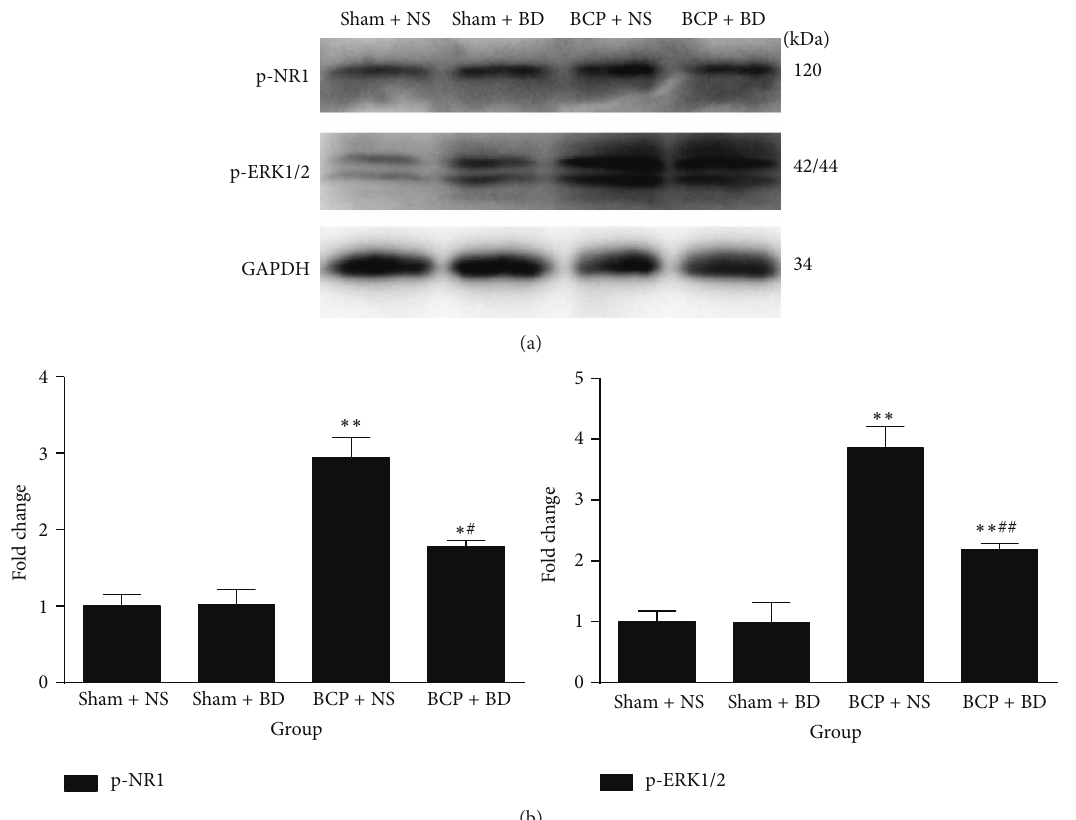
Figure 5: Blocking sigma-1 receptor activation suppressed BCP-induced upregulation of p-NR1 and p-ERK1/2 in the spinal cord. (a) Western blot analysis indicated a significant increase of p-NR1 and p-ERK expression in the spinal cord of BCP rats on day 7. Repetitive treatment with BD1047 significantly decreased these molecules in BCP rats compared with NS-treated BCP group. (b) Quantification of p-NR1 and p-ERK expression level in the spinal cord ( 𝑛 = 4 ). Results are given as means ± SEM. ∗ 𝑃 < 0.05 , ∗∗ 𝑃 < 0.01 versus sham + NS group; # 𝑃 < 0.05 , ## 𝑃 < 0.01 versus BCP + NS